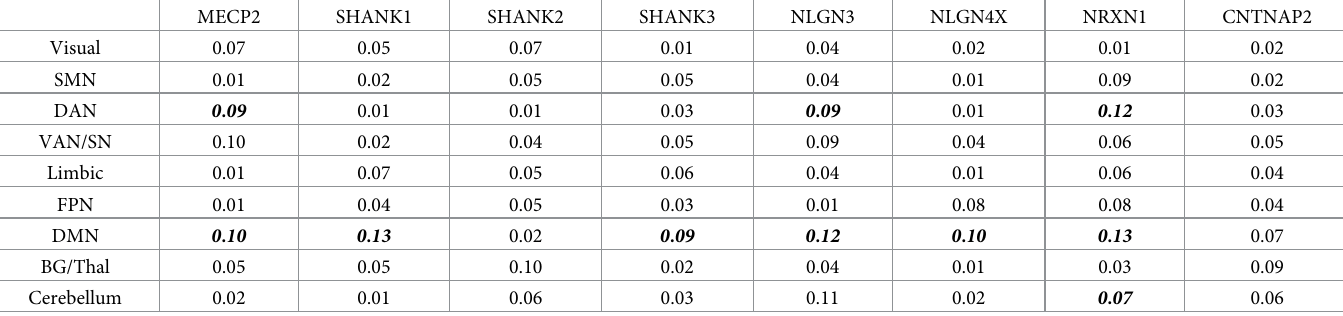
Table 1. The correlation value of gene expression related to areas of GM decrease (ASD < TDCs) in Yeo’s [57] and Brainnetome’s [58] resting-state functional networks. MECP2 SHANK1 SHANK2 SHANK3 NLGN3 NLGN4X NRXN1